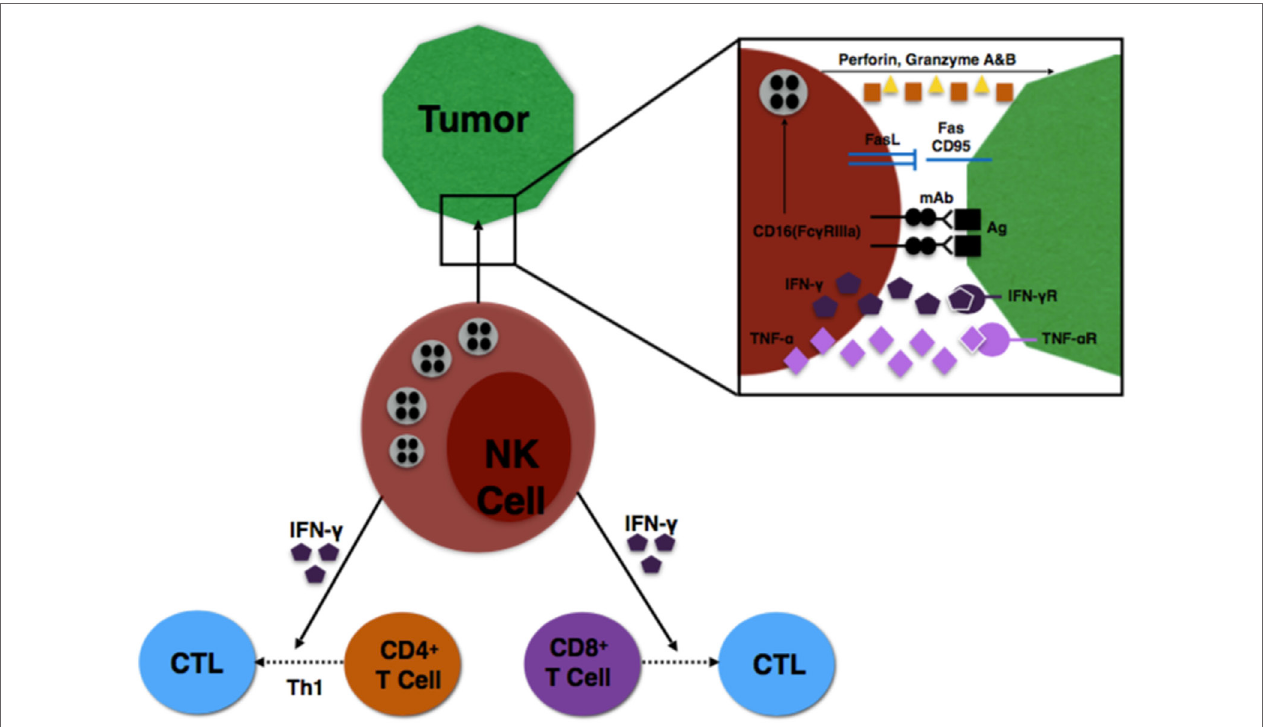
FiGURe 1 | Illustration of NK cell interaction with tumor cells, as well as NK influence on T cell